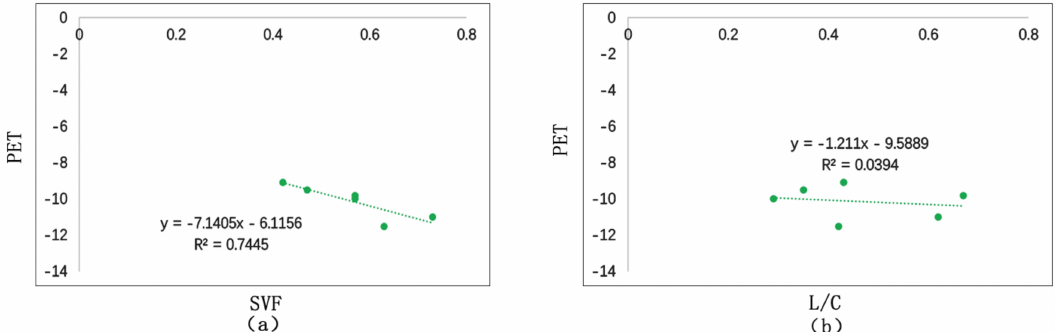
Figure 22. Correlation between SVF, L / C, and PET: ( a ) correlation between SVF and PET; ( b ) correlation between L / C and